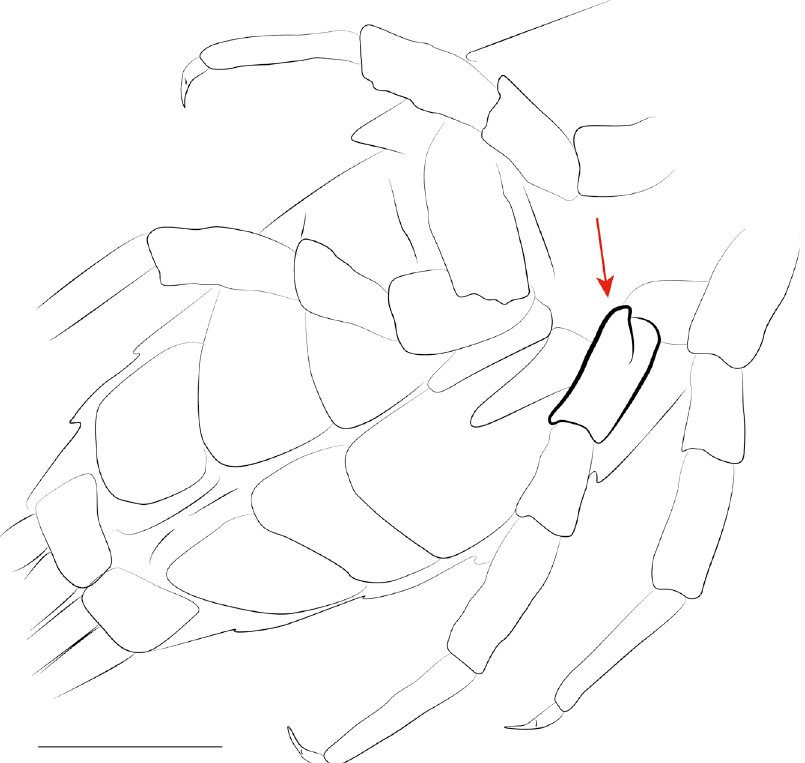
Figure 4. Ventral view of the holotype of Spelunconiscus castroi (MZUSP27521) highlighting the presence of a spur-like structure proximally on the pereopod 7 ischium inner face (red arrow). Scale bar: 1